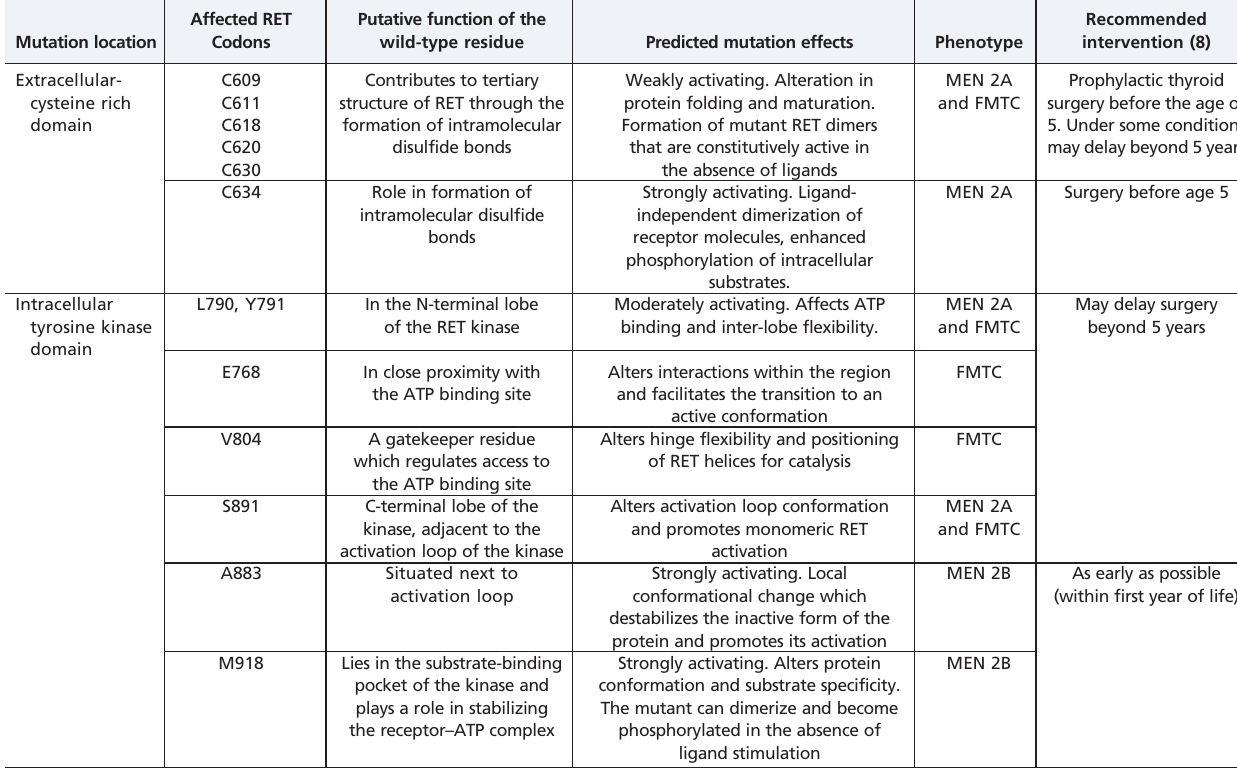
Table 1 - Molecular effects of RET mutations in multiple endocrine neoplasia